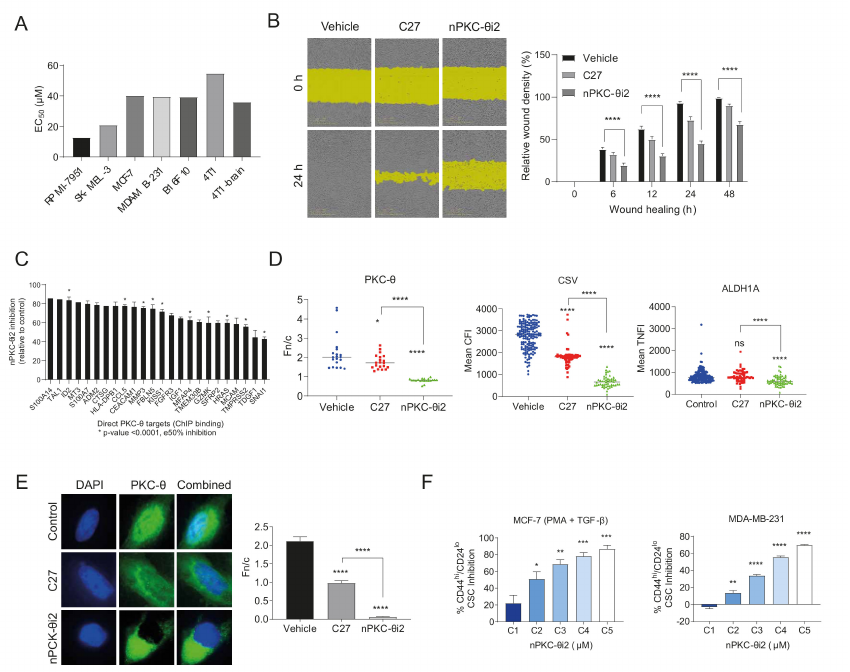
Figure 4. nPKC- θ i2 targets CSC signatures and mesenchymal pathways in metastatic and resistant cancer cell lines. ( A ) WST proliferation assay in melanoma (RPMI-7951, SK-MEL-3), breast cancer (MDA-MB-231), and immunotherapy-resistant (4T1, 4T1 brain clone, and B16F10) cancer cell lines. Cells were treated with nPKC- θ i2 for 72 h before addition of WST reagent. Absorbance was measured at 450 nm. ( B ) Scratch wound assay in MDA-MB-231 breast cancer cells treated with vehicle, C27 (7.5 µ M), or nPKC- θ i2 (25 µ M). Wound healing images were acquired by real-time imaging using